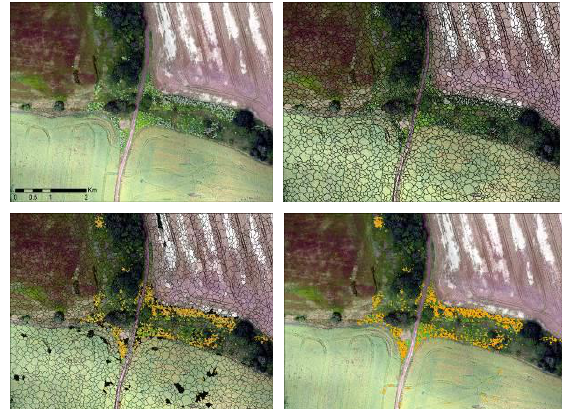
Figure 9 Process of giant hogweed detection from MSS data of UAV origin, OBIA